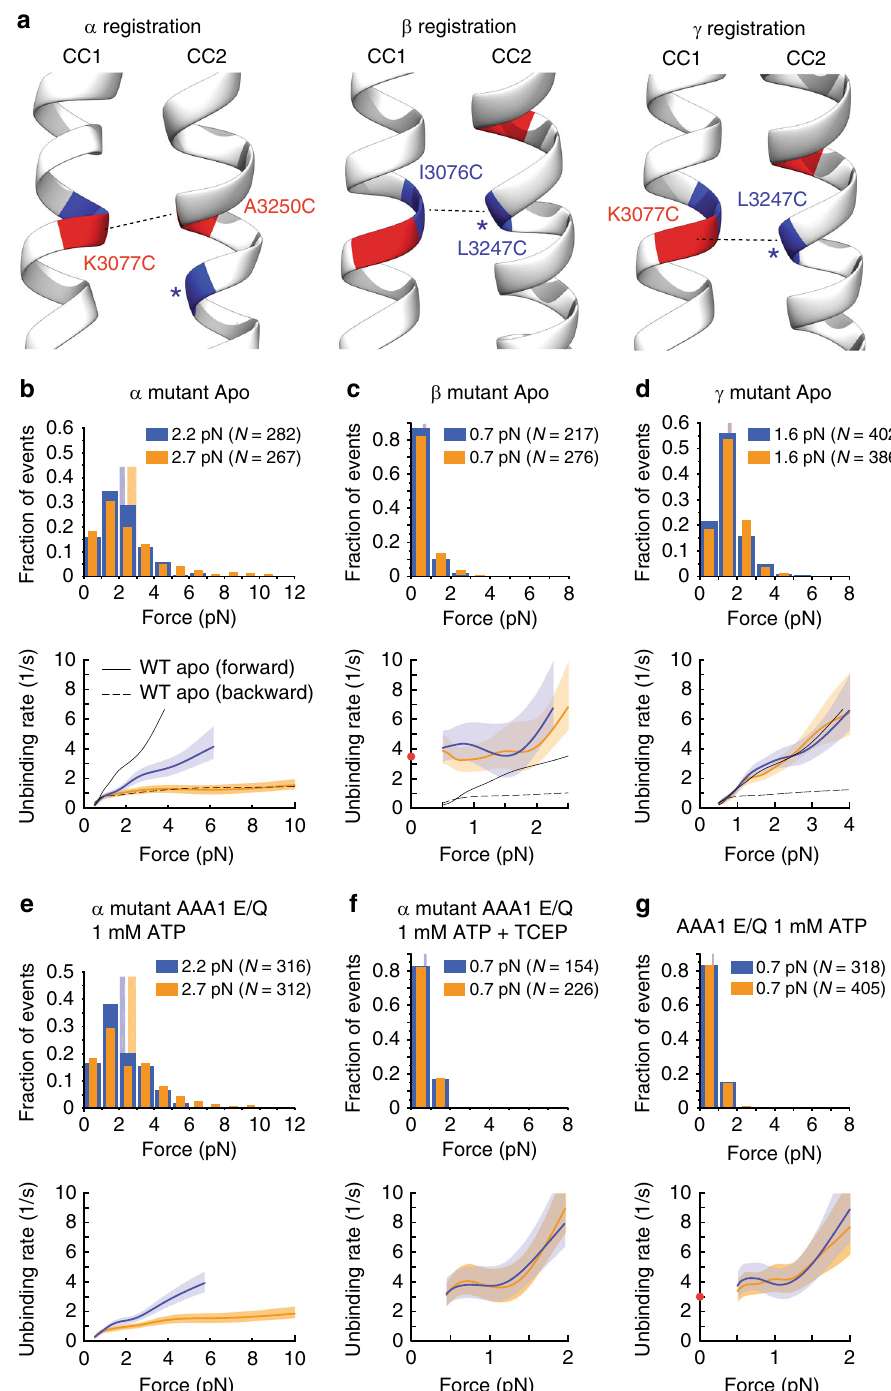
induces a previously undescribed γ -registry in the absence of nucleotides, and upon ATP binding to AAA1, the stalk assumes the β -registry. ring . We previously demonstrated that ATP binding to AAA1 (Fig. 3g) and ADP binding to AAA3 both reduce bond-strength anisotropy, while ADP binding to AAA1 strengthens it 32 , sug- gesting the AAA ring regulates bond strength anisotropy. How- ever, Cleary and coworkers reported results suggesting the